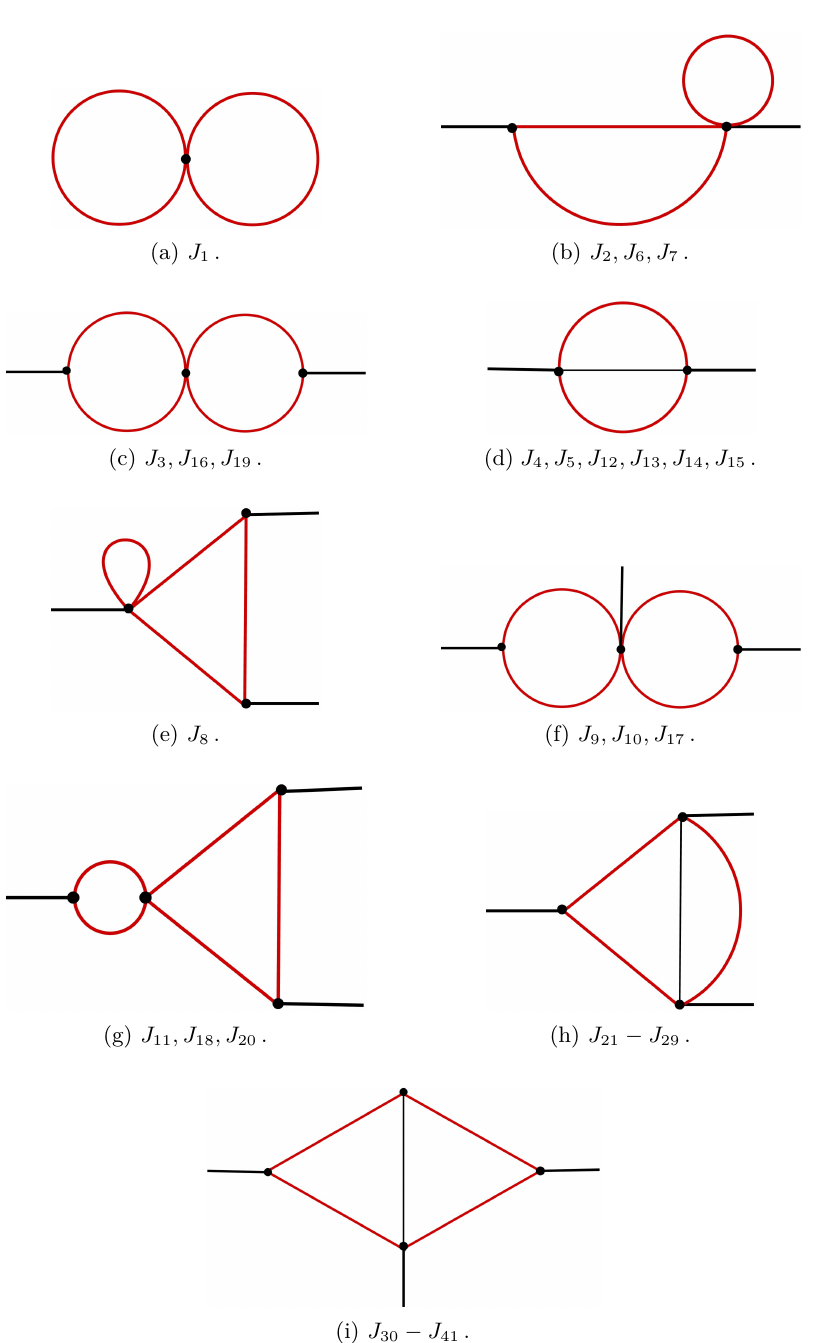
Figure 3 . Topologies relevant to two-loop three-point diagrams in H → ZZ ∗ decay at O ( αα s ) . Light black lines represent massless propagators. The caption of each topology denotes the set of canonical master integrals belonging to that